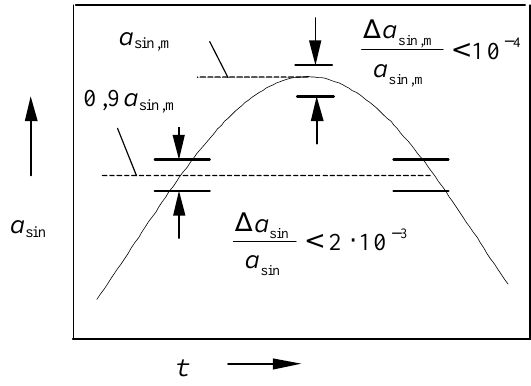
Fig. 6. Simulation results obtained for a sine squared impulse with a duration T sin = 5 ms and peak values in the range from a sin = 100 to 1000 m/s 2 . Quadrature signals are quantized to b = 5 and dis- turbed by 0 . 85 < r < 1 . 15; | p,q | < 0 . 1; | ρ | < 0 . 2 rad.